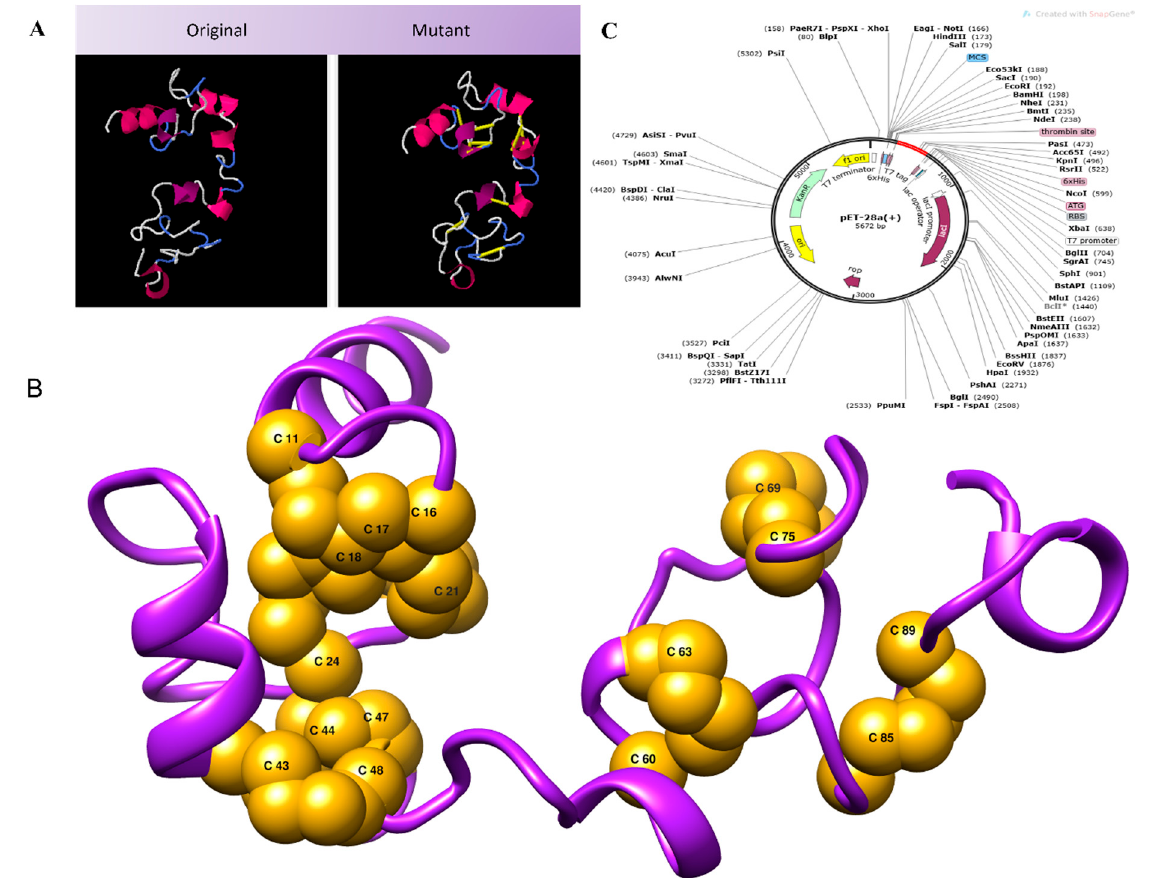
Figure 5. ( A ) Vaccine model along with the mutant model of vaccine. ( B ) 3D structure of the mutant model in which all the residues mutated to cysteine, introducing disulfide bonds. ( C ) Vaccine sequence expressed in pET28a (+) vector .